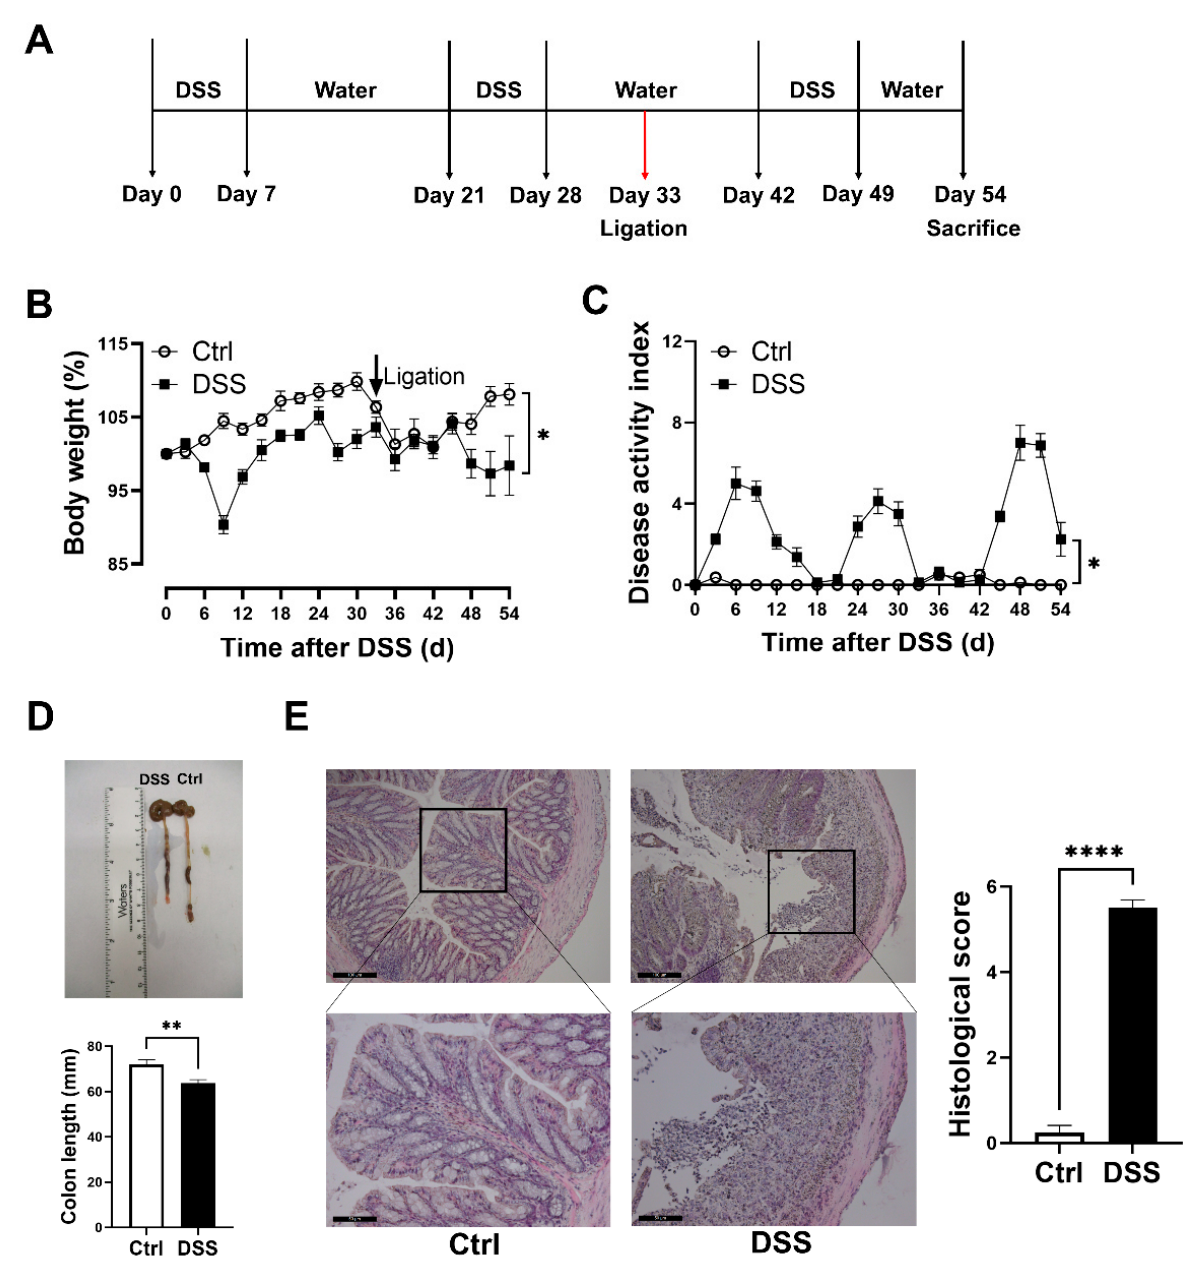
Figure 1. Female mice with chronic colitis displayed significant inflammation in the colon. ( A ) Experimental scheme illustrating DSS treatment and femoral ligation protocol for chronic colitis and limb ischemia models. Changes in ( B ) body weight and ( C ) DAI during DSS treatment. ( D ) Colon length and representative photographs for colon tissue in colitis and control mice. ( E ) Representative images of H&E staining of colon tissue and summary of histological score (scale bar, 100 µ m and 50 µ m). Results are expressed as mean ± SEM. * p < 0.05, ** p < 0.01, **** p < 0.0001, by unpaired 2-tailed Student’s t -test, n = 8 mice in each group. DAI, disease activity index.